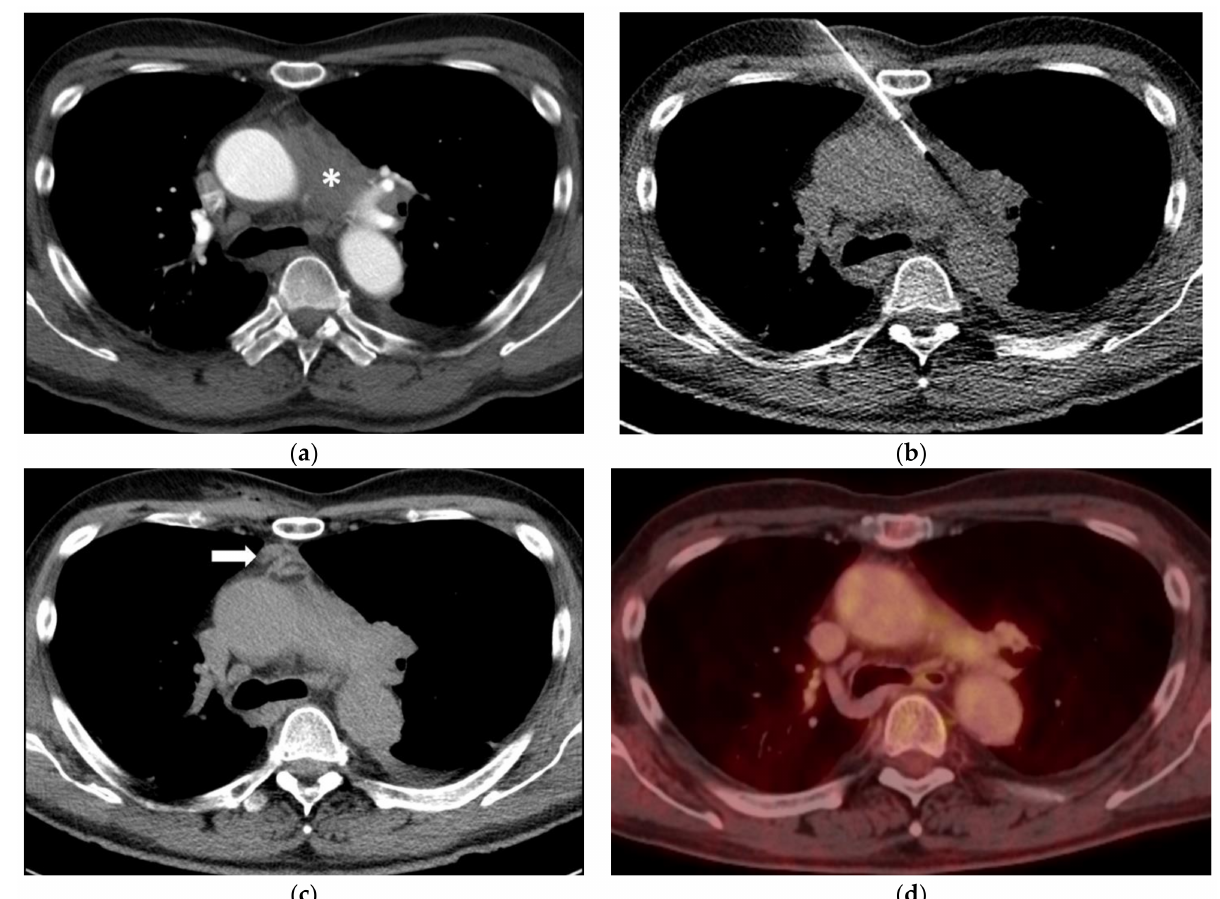
Figure 1. ( a ) A 65-year-old man with ill-defined paraaortic mediastinal mass (asterisk) and synchronous parailiac masses (not shown). ( b ) CT fluoroscopy-guided right parasternal access using an 18-Gauge Tru-Cut biopsy needle. The right internal mammary artery and vein are safely separated from the access trajectory by anterior mediastinal fat tissue. Histopathology reveled a chronic fibrosing mediastinitis in line with an IgG4-related disease. ( c ) Unenhanced CT after the biopsy shows a small self-limiting hemorrhage along the access path (arrow). ( d ) After six years and several doses of Rituximab, follow-up PET-CT (fusion image) confirms a stable remission with a markedly reduced paraaortic mediastinal mass (SUVmax